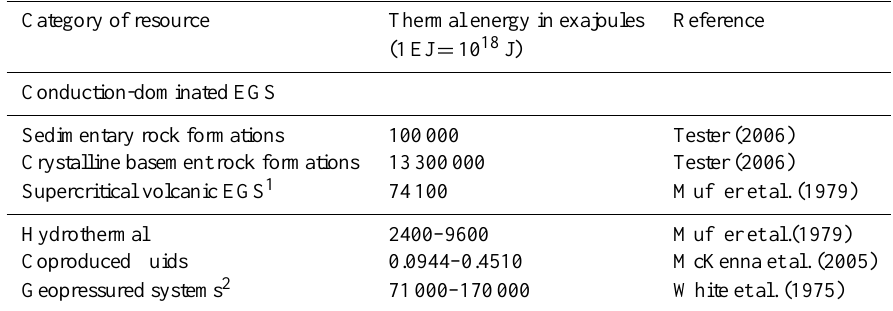
Table 1. Estimated US geothermal resource base to 10km depth by category.